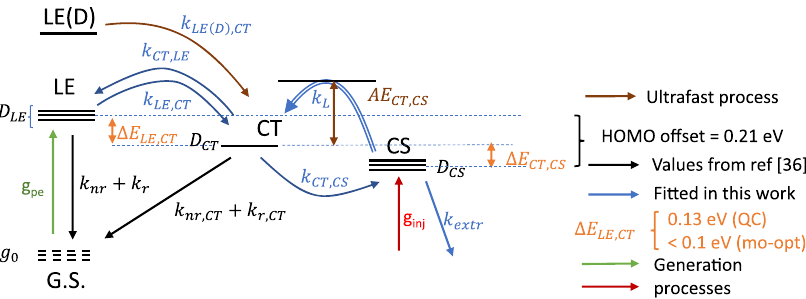
Fig. 3 Photophysical model deployed for multi-objective optimization. Black arrows: known values from the literature; blue: values optimized in this work; orange: driving forces for exciton splitting ( Δ E ) and charge separation ( Δ E ), estimated from quantum chemistry (QC) and multi-objective LE ; CT CT ; CS modelling. Bimolecular processes given as double lines. A number of horizontal lines indicate relative state abundance g (not to scale). Dashed horizontal lines refer to states not explicitly included in the rate equation scheme. The states are generated either by optical excitation (arrow labelled g pe ) or by charge injection (arrow labelled g i nj ), and AE CT,CS is the formal activation energy of CS formation in the